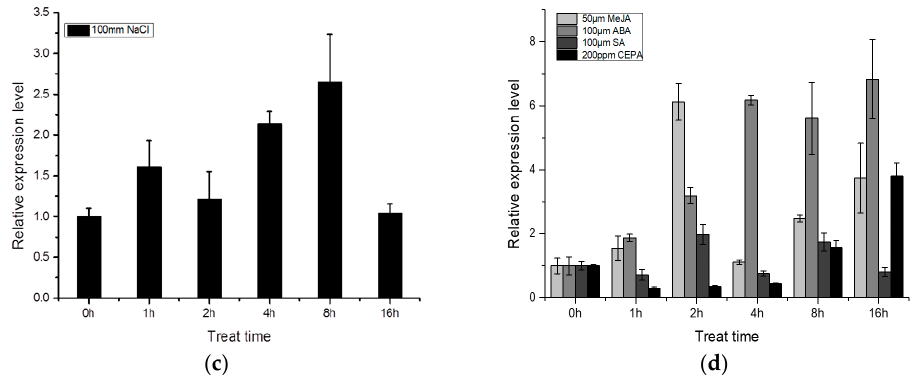
Figure 5. Responses of BocMBF1c to various abiotic treatments. ( a ) semiRT-PCR (reverse transcription PCR) and qPCR were used to determine the expression profile under heat stress (37 °C ) in the leaf tissue of Chinese kale. ( b ) Expression of BocMBF1c under cold treatment (4 °C ). semiRT-PCR and qPCR were used to determine the expression profile under cold condition in the leaf tissue of Chinese Kale. ( c ) Responses of BocMBF1c to salinity treatment. ( d ) Expression of BocMBF1c after applying hormones. All analyses used Tubulin8 as an internal reference gene, and all data shown were normalized to mock treatments. Data shown are the mean ± SD of three biological replicates.